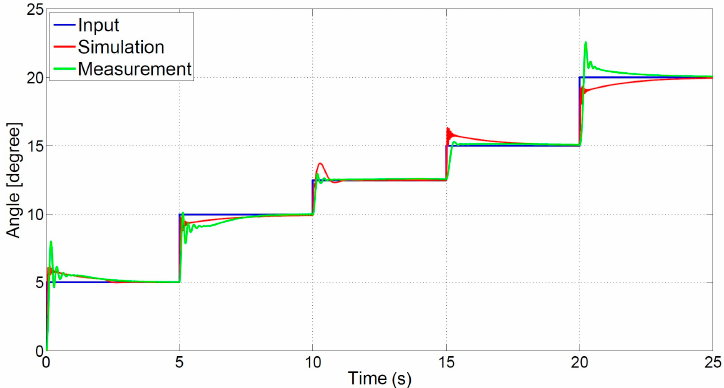
Figure 12. Simulation and real measurement of the BLDC motor using steps.